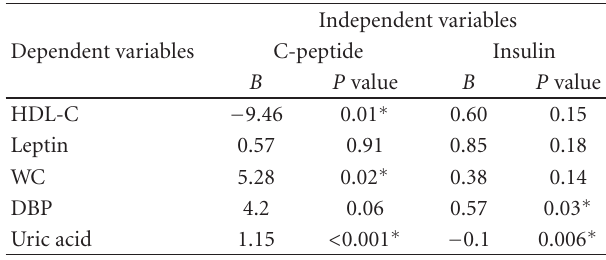
Table 3: Linear regression analyses of fasting C-peptide versus fasting insulin as independent variables and other biomarkers as dependent variables in overweight/obese group ( n =